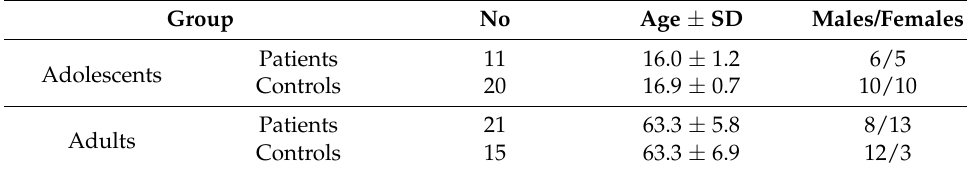
Table 1. Basic demographic data of depressed patients and controls.